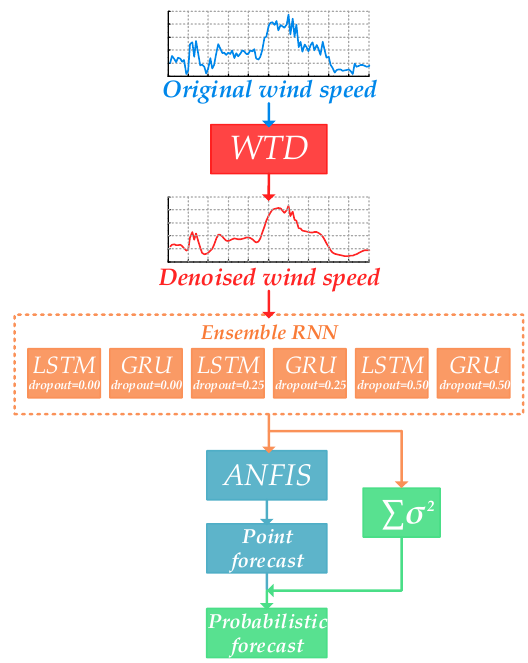
Figure 2. The entire architecture of the proposed probabilistic forecasting model.